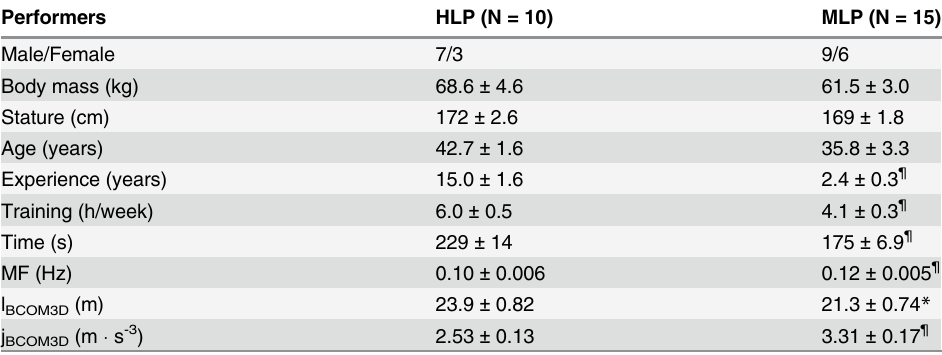
Table 2. Main characteristics of the performers and kinematic components of the video clip perfor- mances at “ normal speed ” (data are means ± SE).